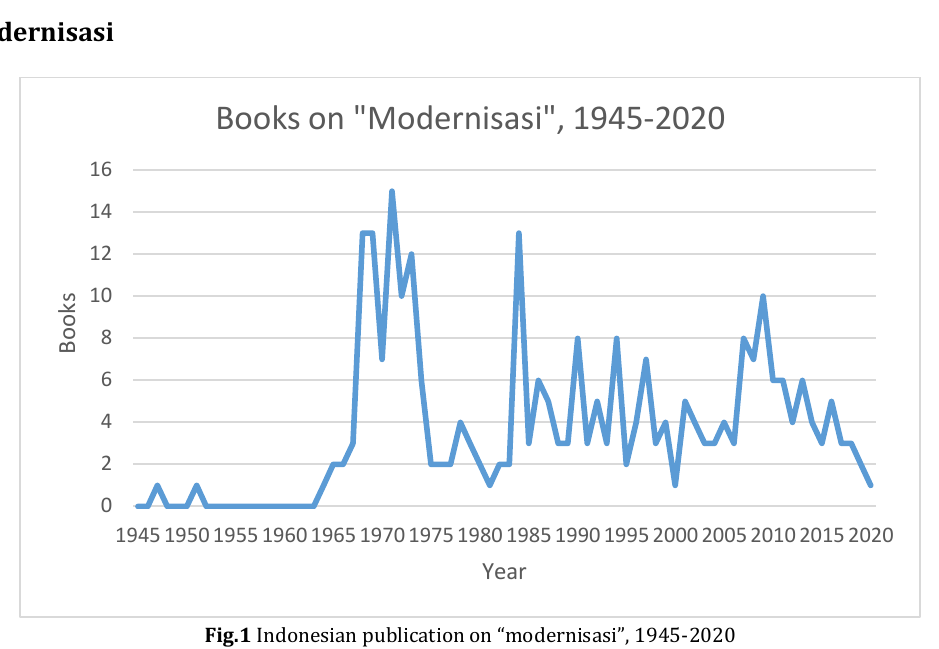
Fig.1 I ndonesian publication on “modernisasi”, 1945